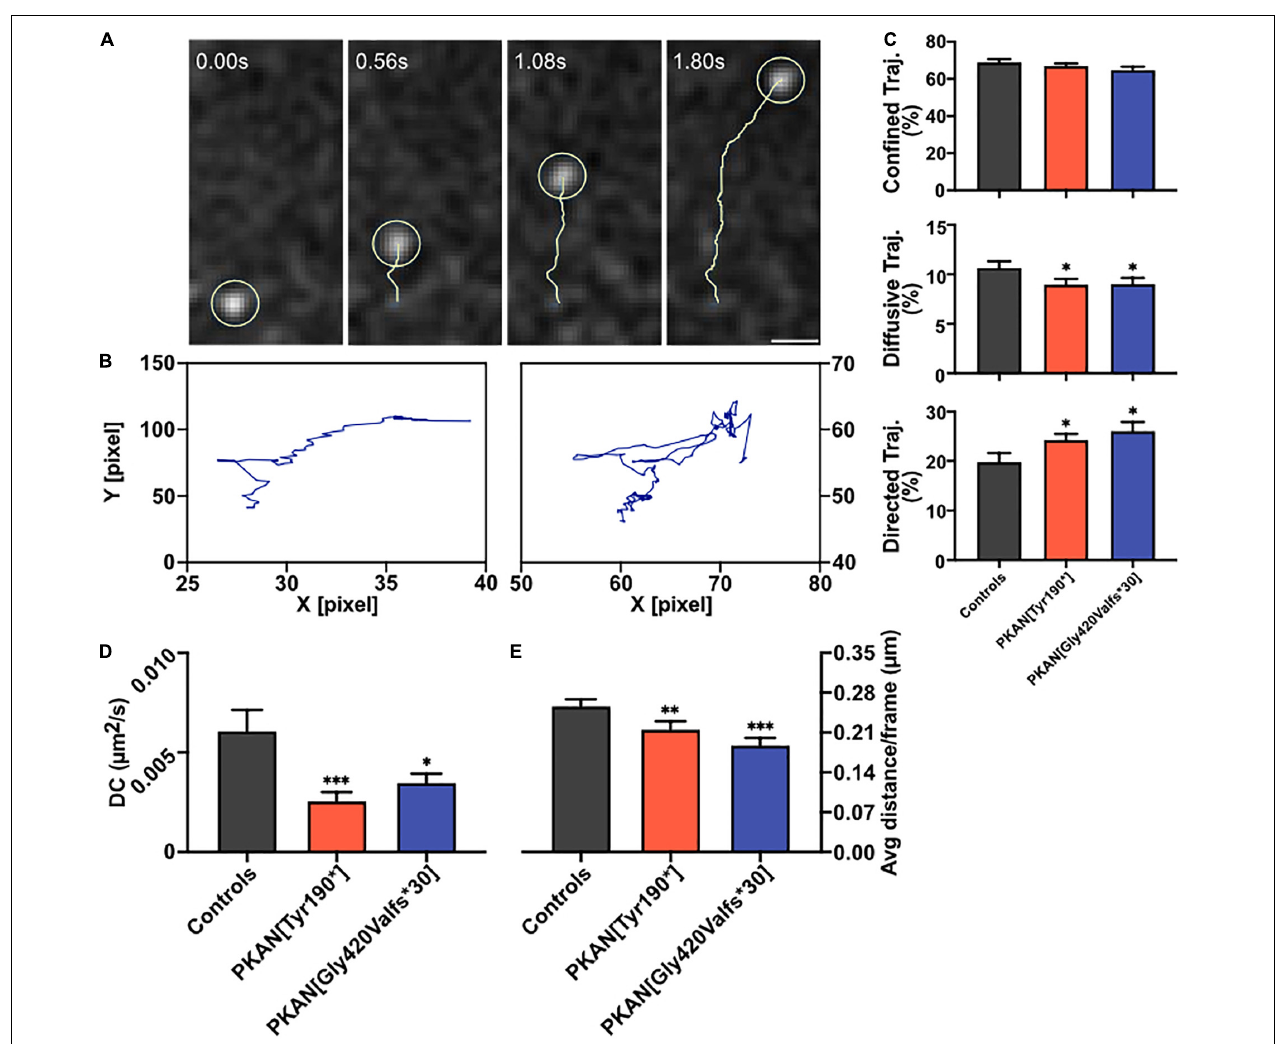
FIGURE 3 | Endosomal dynamics. Astrocytes expressing SynaptoZip were pulsed with 5 nM Synbond for 5 min to tag only a ctive early endosomes which undergone at least one exo-endocytosis cycle . The fate of active endosomes was followed by high-speed live imaging and trajectories were analyzed. (A) An exemplar trajectory (yellow track) of a single endosome (light yellow circle, scale bar 1 µ m). (B) Two exemplar trajectories represent a directed (left) and diffusive behavior (right). (C) Analysis of the diffusional behavior in control and PKAN astrocytes endosomes, bars are the mean percentage of trajectories that follows a confined (upper panel), diffusive, or directed (lower panel) type of motion. (D) Bars show the mean Diffusion Coefficient (DC) in astrocytes from control and PKAN in different conditions, calculated from dynamics of live-tracked endosomes enriched in Synbond. (E) Mean average distance covered by live-tracked endosomes in controls and PKAN patients [ (C–E) statistical tests were run vs. controls, Mann–Whitney test, n ≥ 31 cells analyzed for each, from at least three independent replicates]. Error bars are SEM for all. ∗ p < 0.05; ∗∗ p < 0.01; ∗∗∗ p < 0.001; ∗∗∗∗ p < 0.0001 for